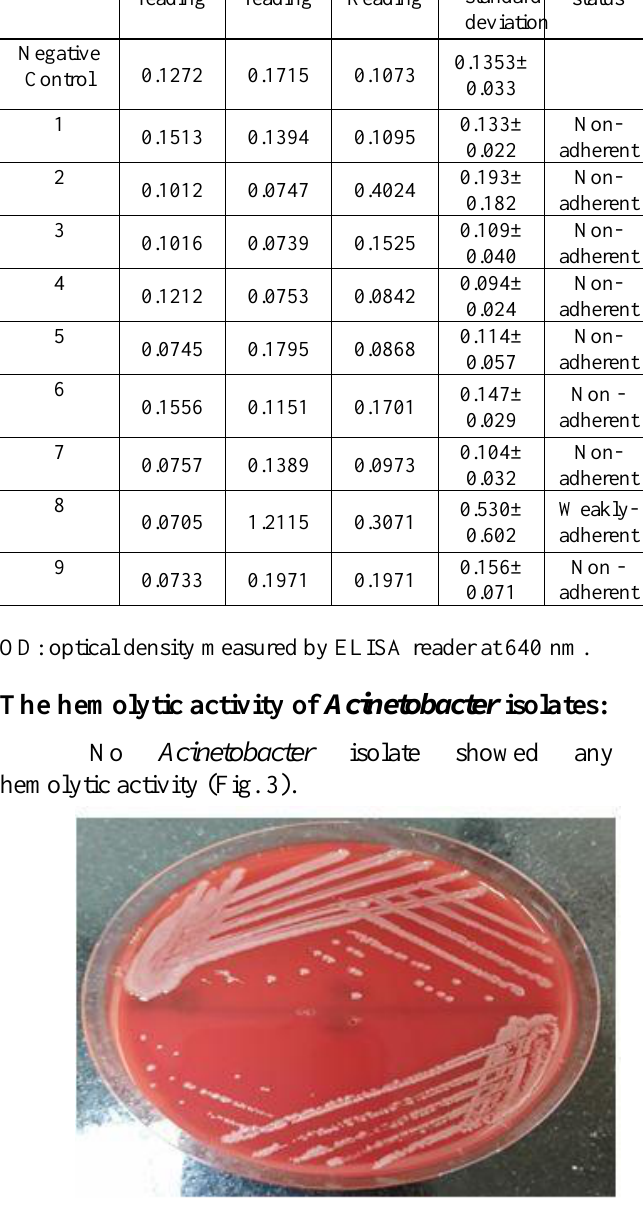
Fig. 3: Non-hemolytic Acinetobacter spp on blood